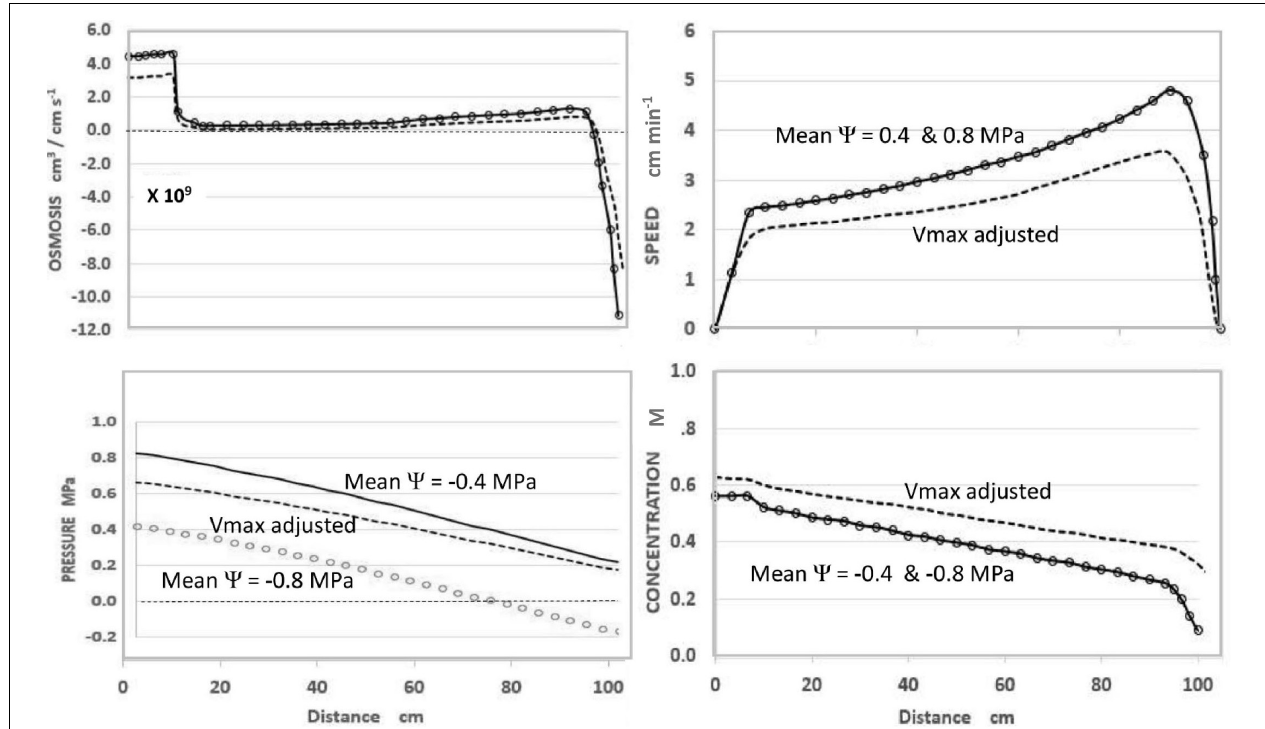
FIGURE 1 | Effects of apoplastic water potential ( (cid:57) ) and effective unloading conductance (i.e., EUC assigned as Vmax of the Unloading enzyme system). Solid Traces Mean (cid:57) = − 0.4 MPa with Vmax = − 1.72 × 10 − 10 mol sec − 1 . Open Circles Mean (cid:57) = − 0.8 MPa with Vmax = − 1.72 × 10 − 10 mol sec − 1 . Dashed Traces Mean (cid:57) = − 0.8 MPa with Vmax = − 1.35 × 10 − 10 mol sec − 1 . Plotted from same data as Goeschl (2019, Figures 7–5) where the term mPa should have been MPa